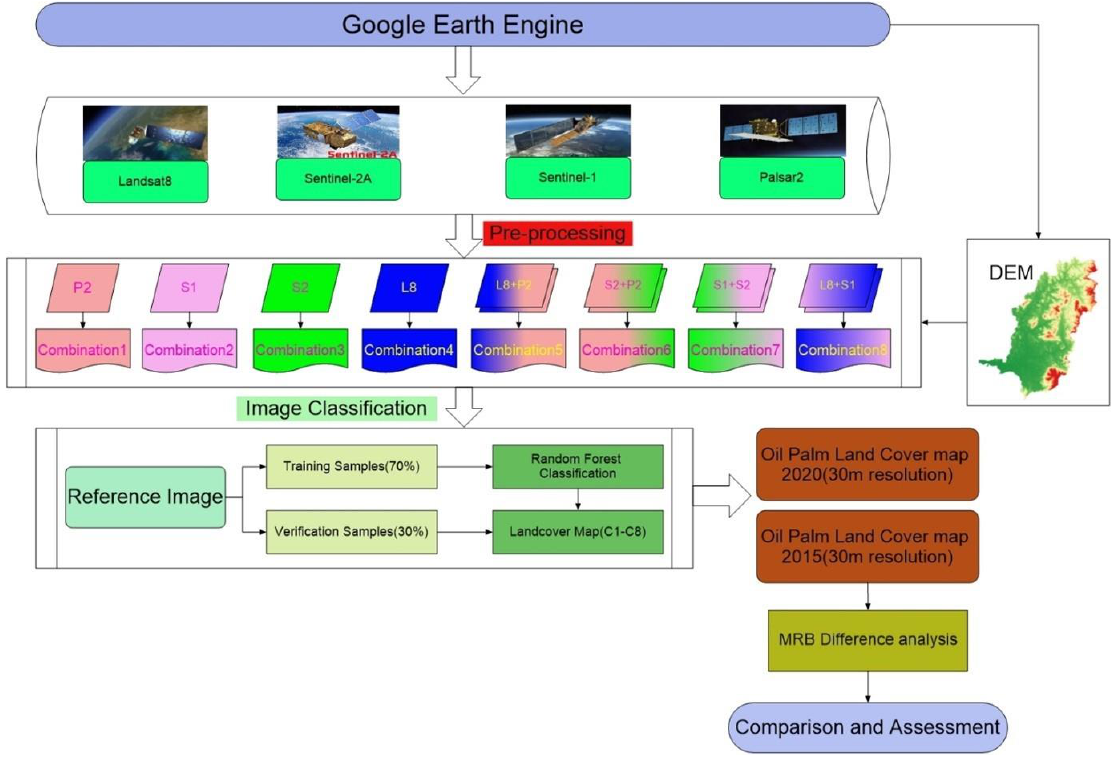
Figure 3. Methodology flow chart of this study. Xu et al.